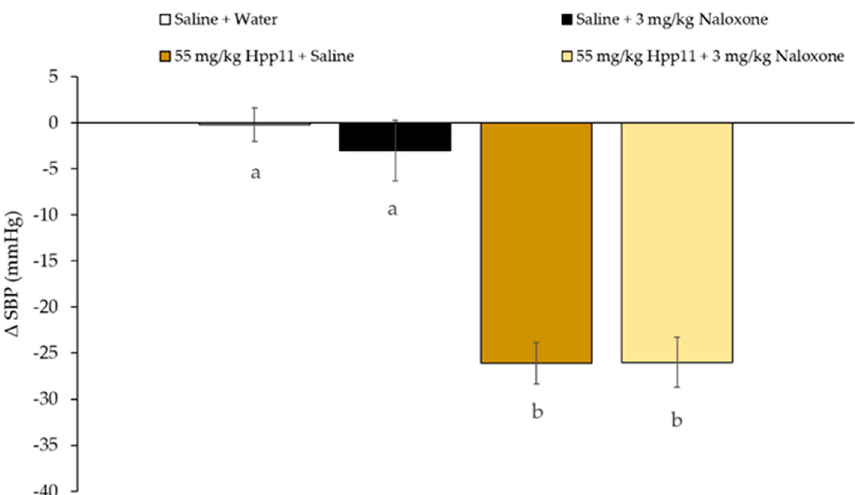
Figure 2. Changes in systolic blood pressure (SBP) caused in spontaneously hypertensive rats after 6 h post-administration of the di ff erent treatments: oral administered water + intraperitoneal injected saline, oral administered saline + intraperitoneal injected 3 mg / kg bw Naloxone, oral administered 55 mg / kg Hpp11 + intraperitoneal injected saline or oral administered 55 mg / kg bw Hpp11 + intraperitoneal injected 3 mg / kg bw Naloxone. Data are expressed as mean ± standard errors. The experimental groups always had six animals each. Di ff erent letters represent statistically significant di ff erences ( p < 0.05). P was estimated by one-way